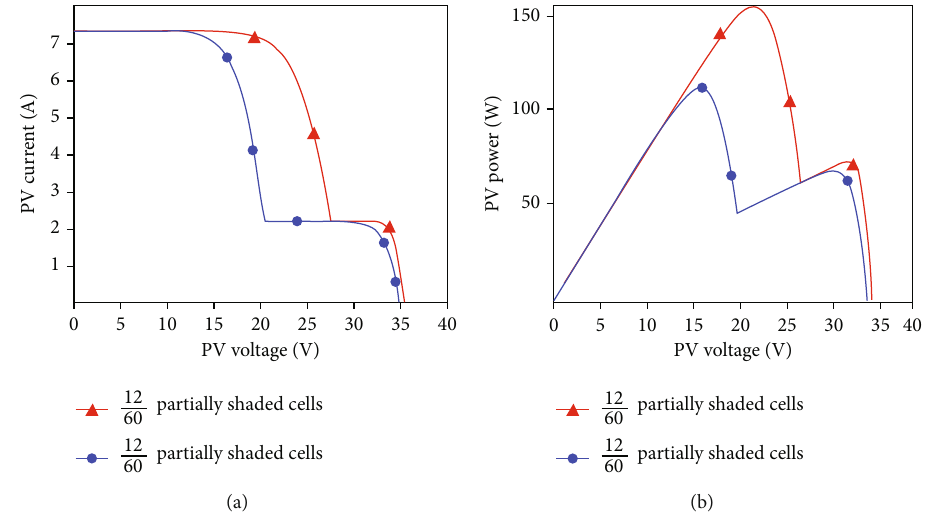
Figure 3: Partially shaded PV panel. (a) I-V curve. (b) P-V